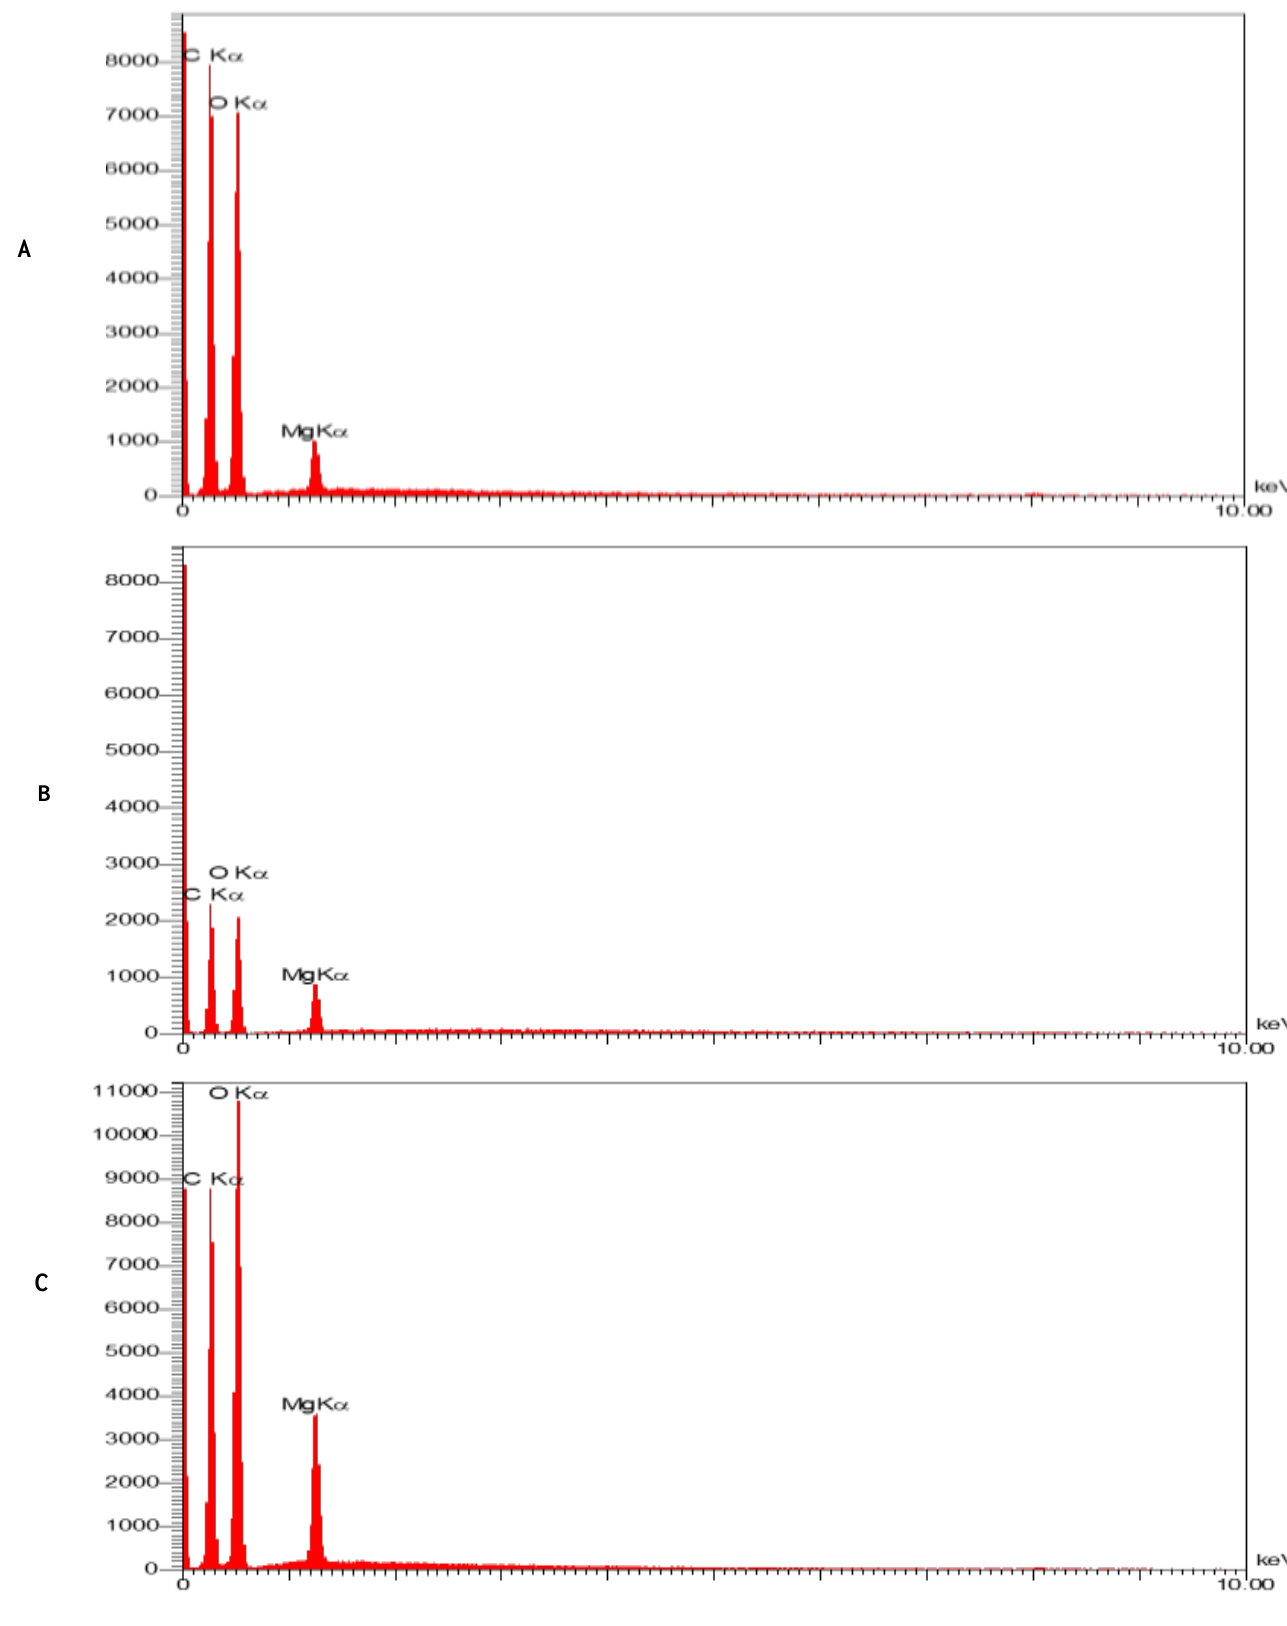
Figure 3 (A, B, C) EDX spectra of CHT hybrid materials for (0.04, 0.06, and 0.08) g of MgO nanoparticles, respectively. It demonstrates diverse concentrations of (C, O, Mg) elements in the scanned